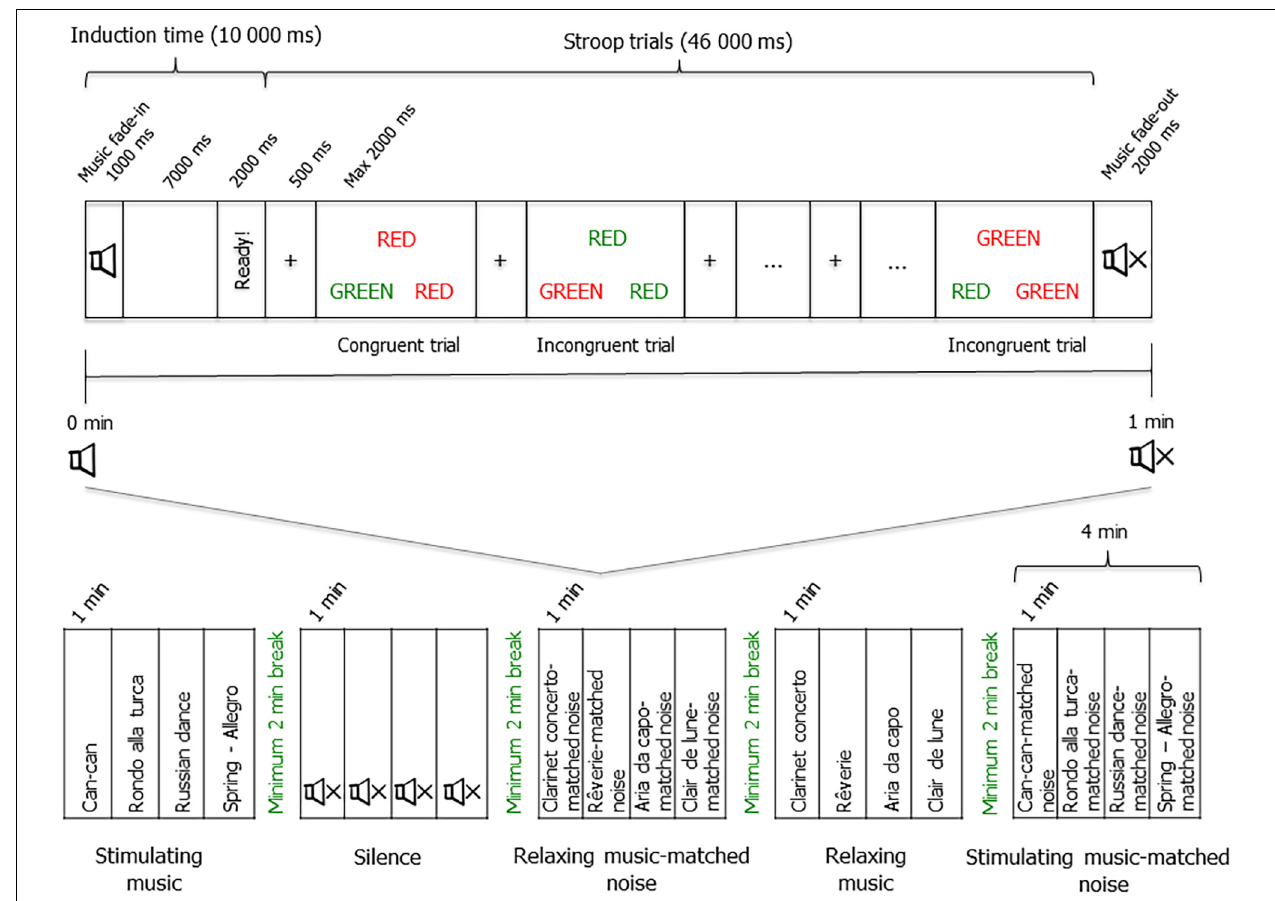
FIGURE 1 | Schematic representation of the experimental procedure and experimental Stroop